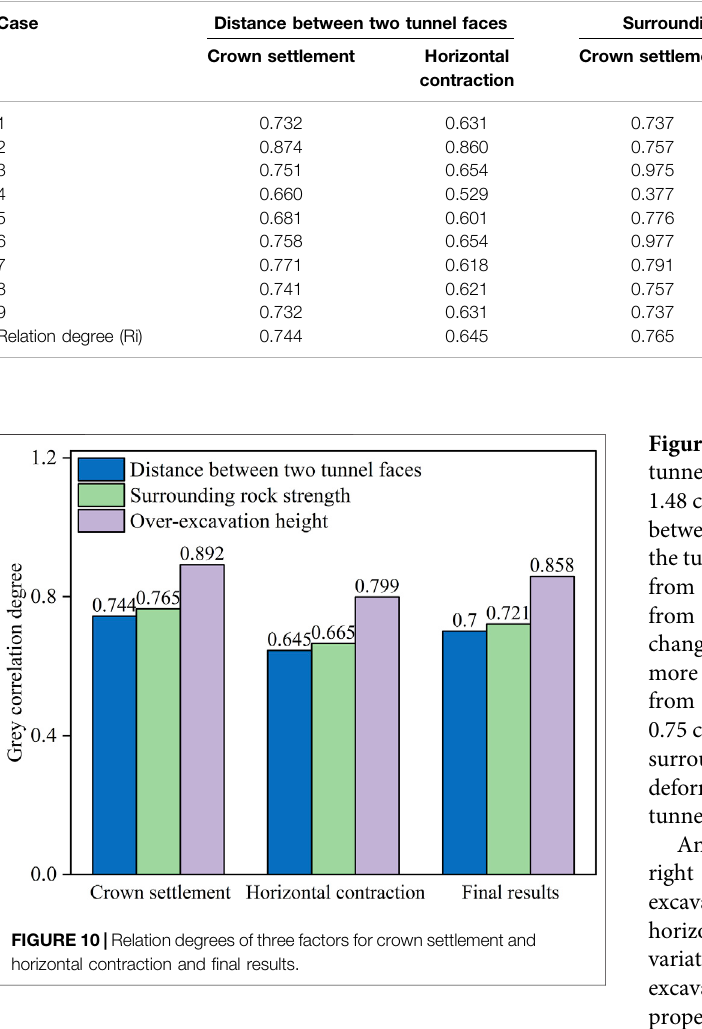
Frontiers in Earth Science |